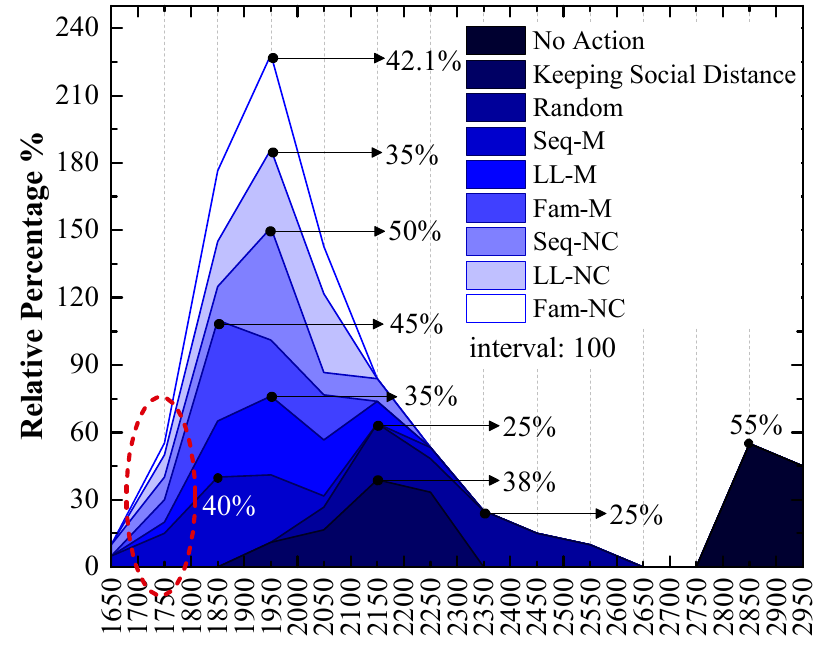
Figure 7. The relative frequency of cumulated confirmed cases using various strategies in the 1st scenario. The x-values of the peak values express the cumulative confirmed number with the highest probability.